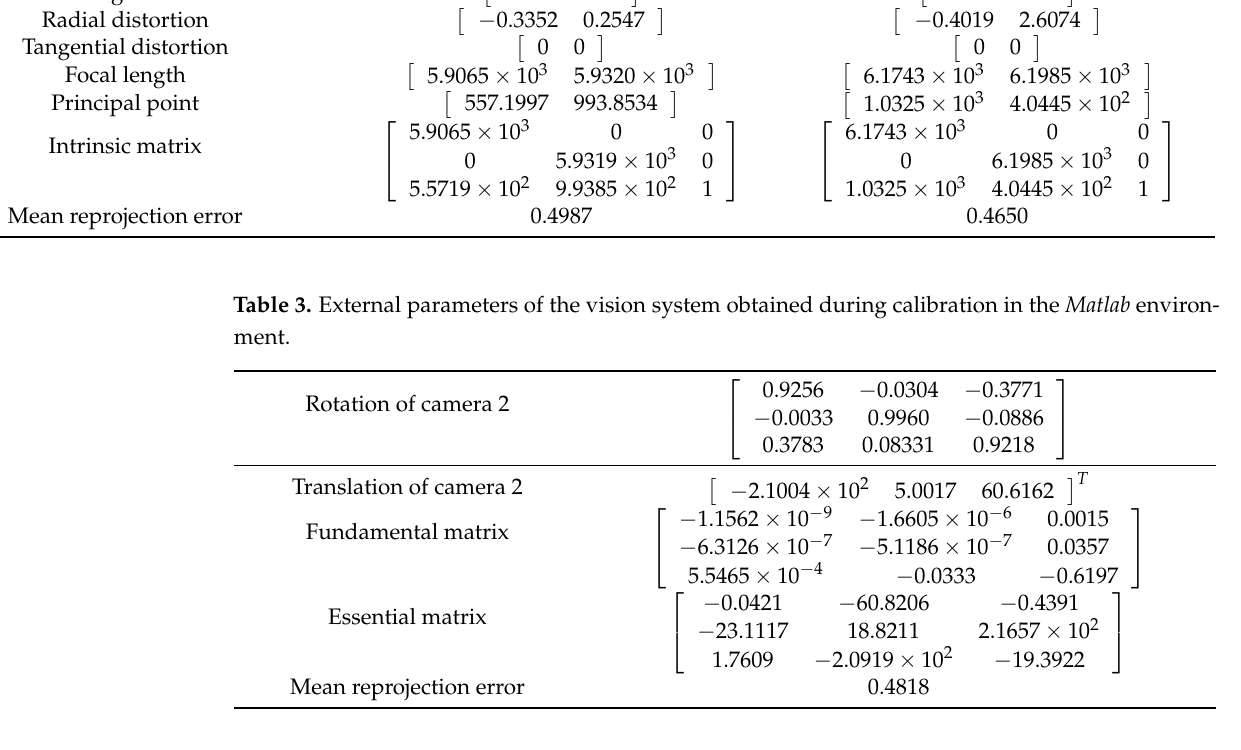
Table 2. Internal camera parameters obtained during calibration in the Matlab environment. Left Camera Right Camera Image size